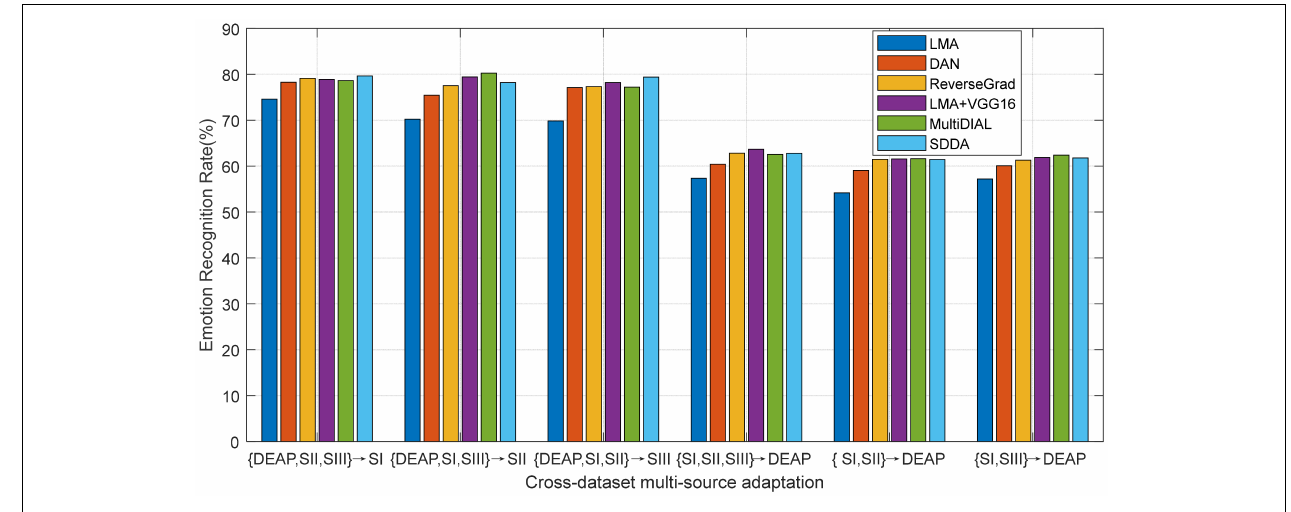
FIGURE 6 | Emotion recognition accuracies of different methods using deeply extracted features (SI: Session I, SII: Session II, SIII: Session III). TABLE 2 | Multi-source adaptation emotion recognition accuracies of derived methods as well as LMA. Method